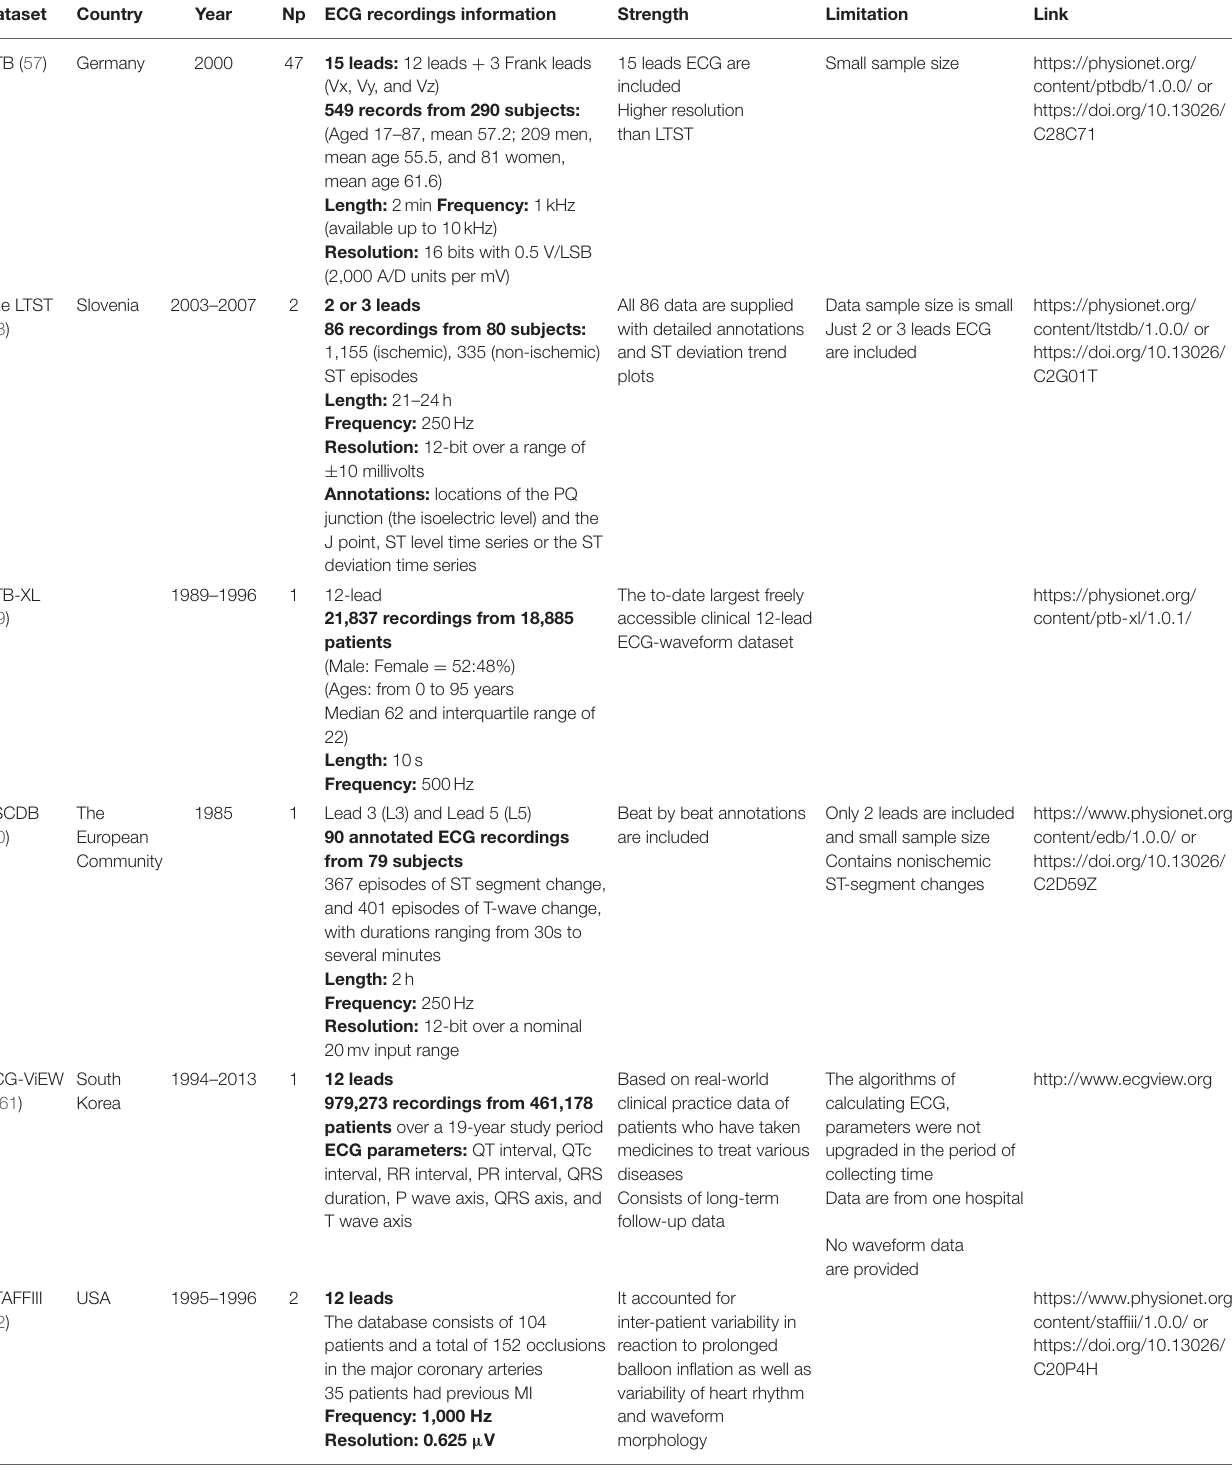
TABLE 3A | Properties of the collected databases used in the research of MI detection and location.